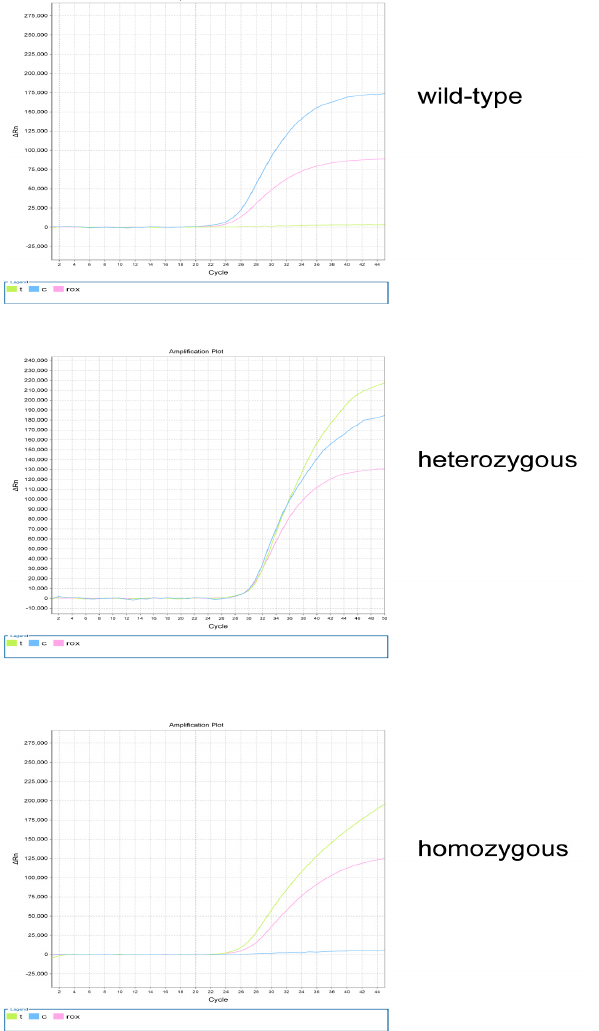
Figure 1. MTHFR genotyping. The wild − type genotypes include MTHFR 677CC, MTHFR 1298AA, and MTRR 66AA; the heterozygous genotypes include MTHFR 677CT, MTHFR 1298AC, and MTRR 66AG; and the homozygous genotypes include MTHFR 677TT, MTHFR 1298CC, and MTRR 66GG; t represents the FAM fluorescence channel, c represents the VIC fluorescence channel, and ROX represents internal